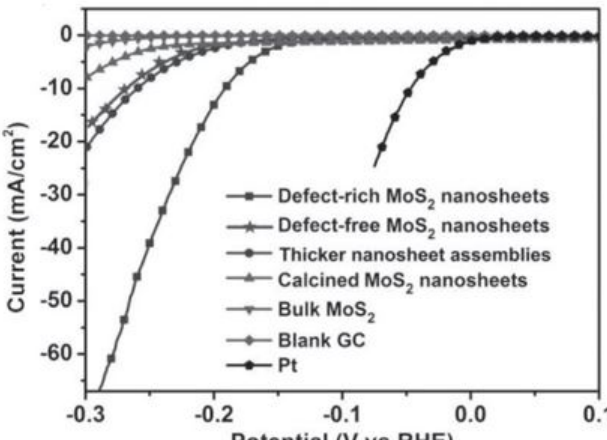
Figure 16. Polarization curves of various samples (defect-rich and defect-free MoS 2 , thicker nanosheet (NS), calcined MoS 2 , bulk MoS 2 , blank GC, and Pt) Table 2. HER parameters (number of active sites (10 −3 mol g −1 ), turnover frequency (TOF) (s −1 ), Tafel slope (mV dec −1 ), Tafel region (mV), j 0 (μA cm −2 ), and j (mA cm −2 )) of various MoS 2 samples [30]. Materials (a)